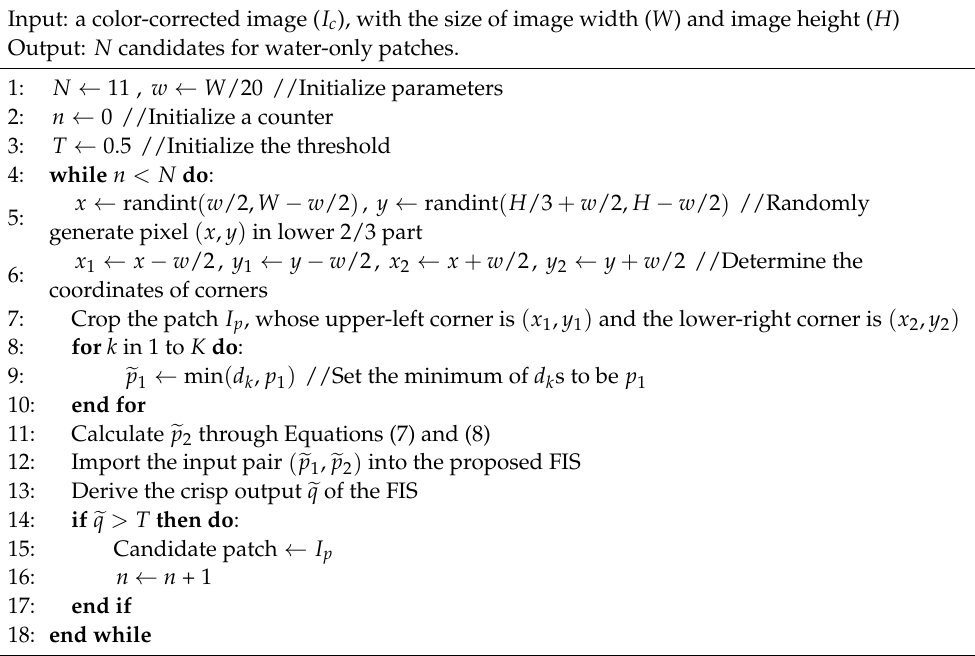
Algorithm 2: Proposed water-only candidate extraction algorithm